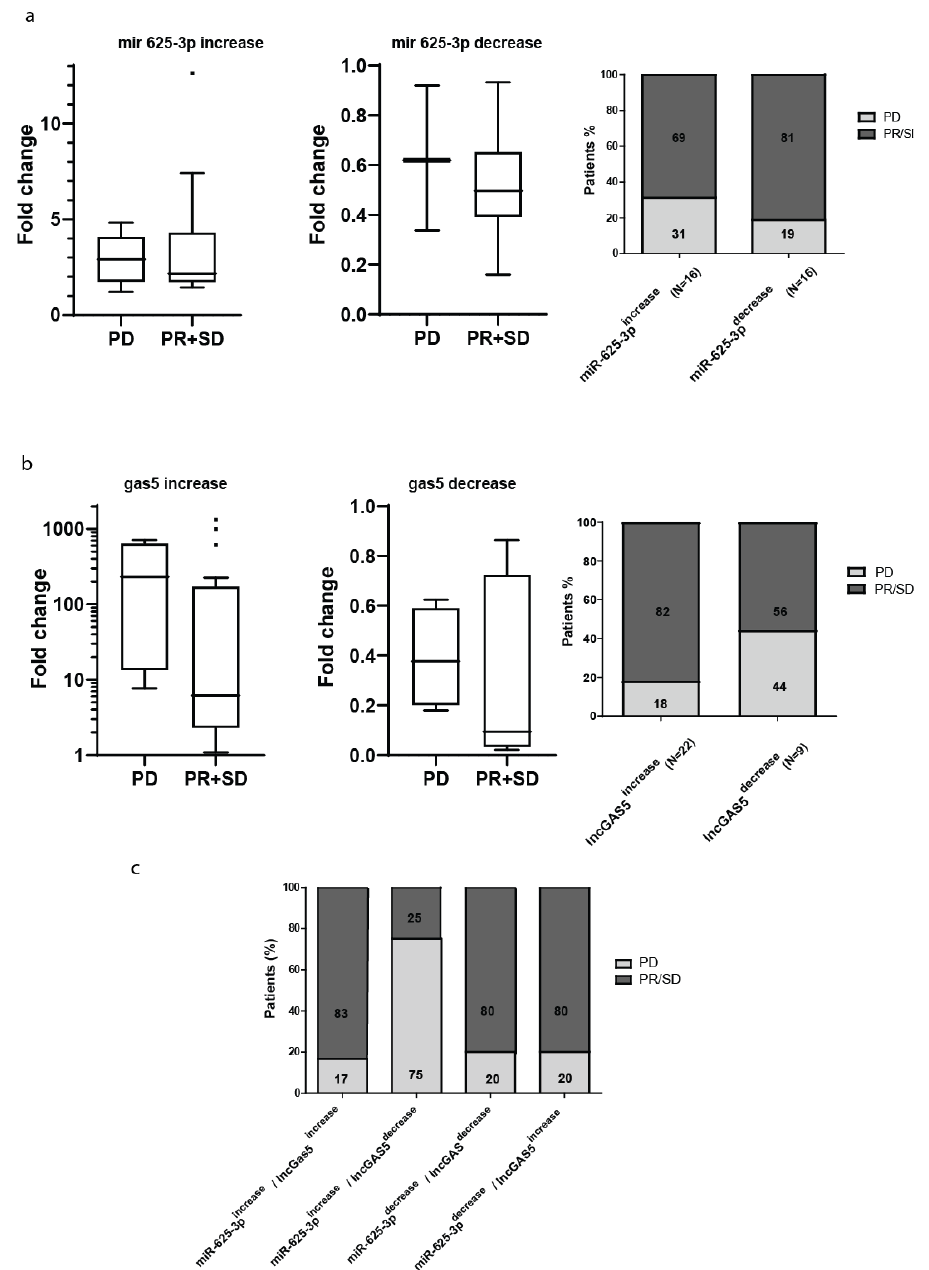
Figure 2. Increase of circulating miR-625-3p in combination with decrease of circulating GAS5 associates with disease progression. Relative changes of circulating miR-625-3p ( a ) and GAS5 ( b ) before and after chemotherapy defined patients groups where these circulating nucleic acids displayed increased or decreased levels. Neither relative changes in miR-625-3p nor in GAS5, was significantly (Fisher’s test) associated with response to chemotherapy defined as partial response (PR) or stable disease (SD) and compared to progressive disease (PD). The Tukey box plots of fold change expression have median values represented by the line within the boxes and the lower and upper limit of the boxes denote the 25 th and 75 th percentile while dots represent outliers ( c ). Combined increasing circulating levels of miR-625-3p and decreasing circulating levels of GAS5 were significantly ( p = 0.0393, Fisher’s test) associated with the progressive disease (PD) after chemotherapy.